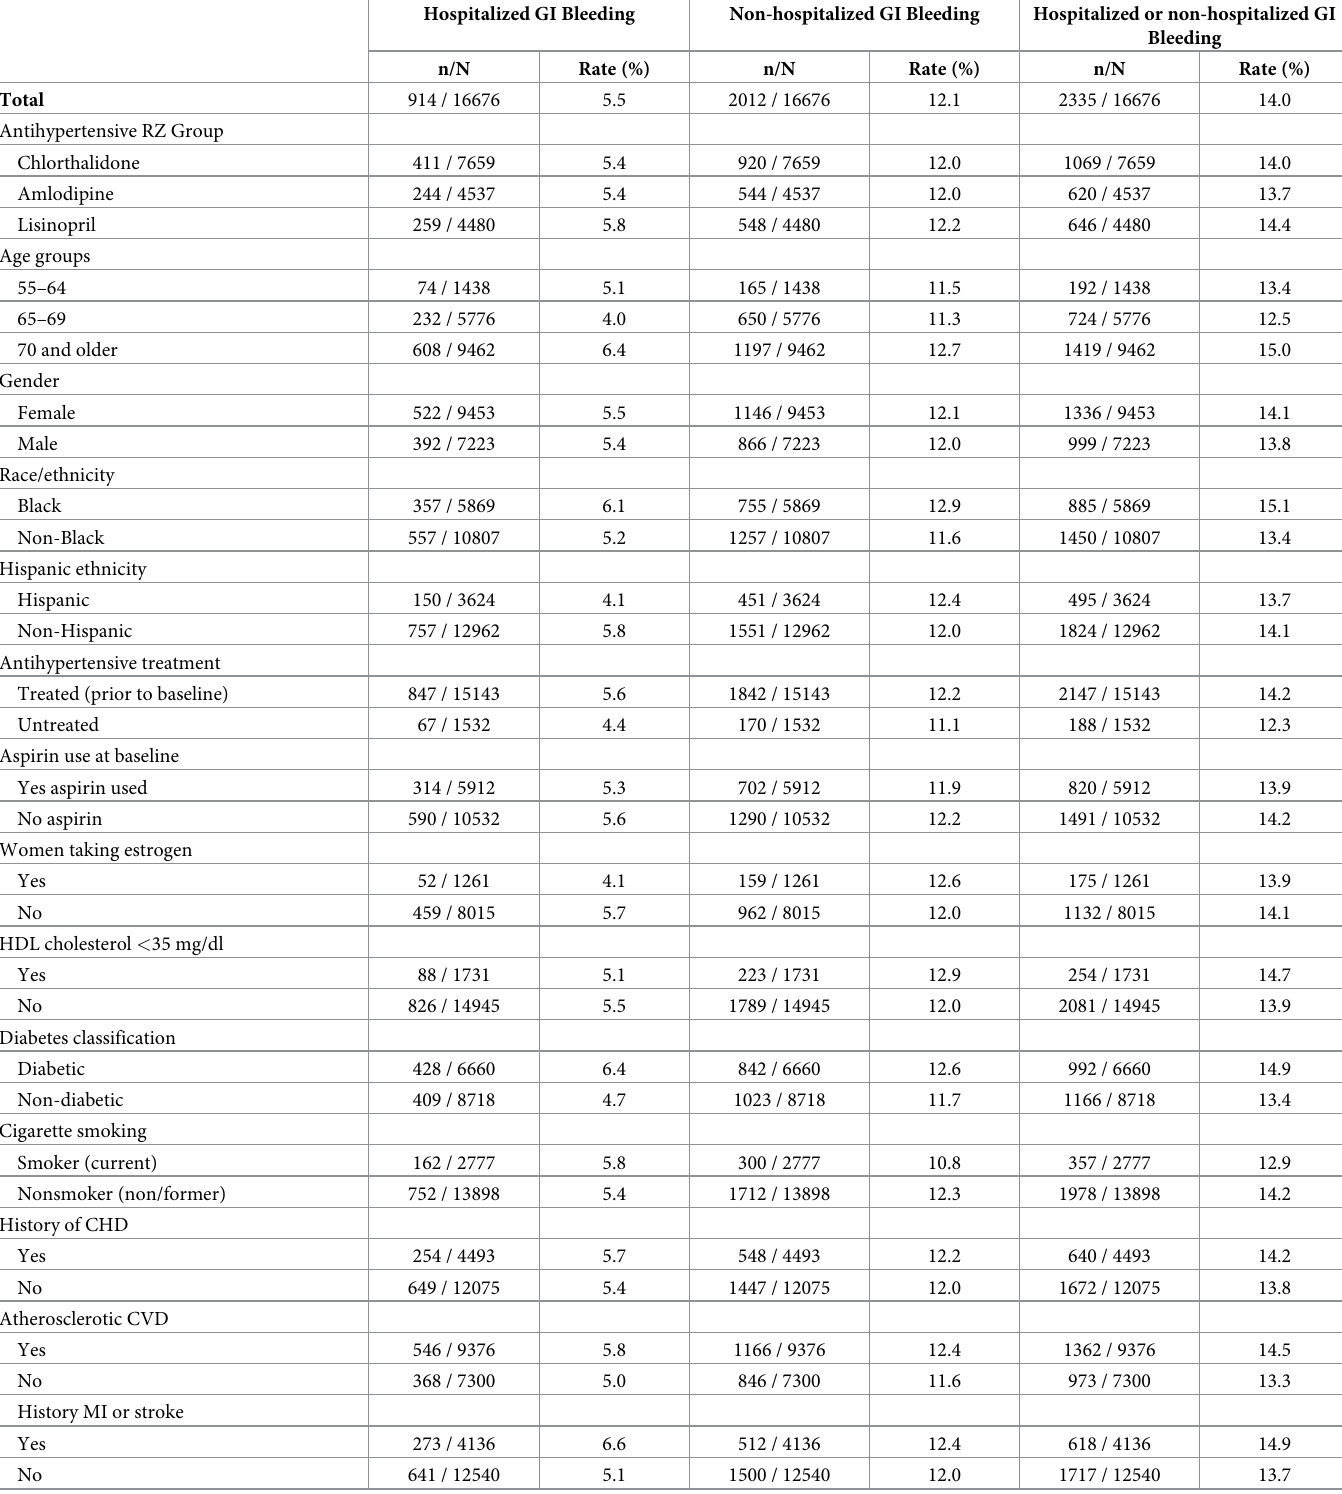
Table 2. Cumulative incidence of hospitalized GI bleeding, non-hospitalized GI bleeding, and combined all GI bleeding in-trial from 1994 through